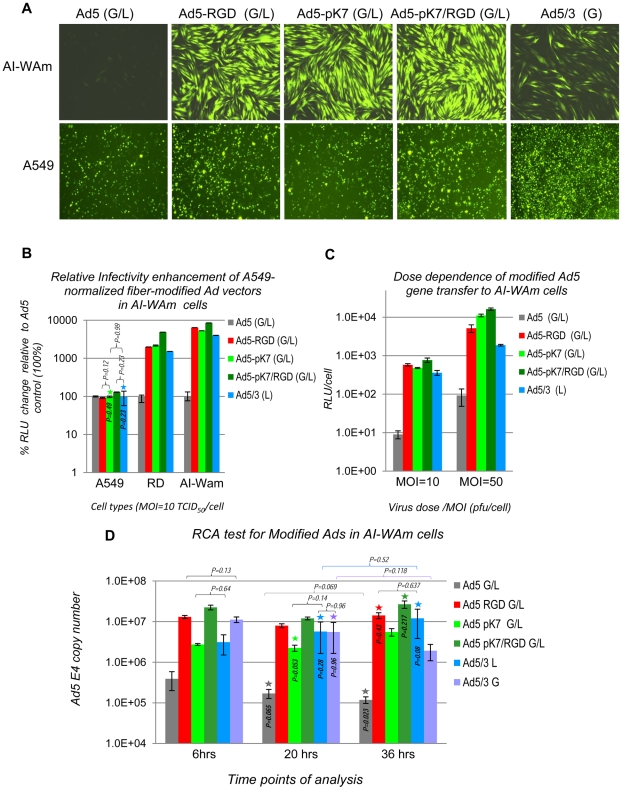
Augmentation of Ad5 gene transfer to AI-WAm cells by Ad5 vectors with various fiber modifications.
A. Representative fluorescent microscopy images of cells infected with the array of recombinant Ad5 vectors with genetically-modified fibers shown on Fig. 4. Relative gene transfer efficiencies in the AI-WAm and A549 cells were assessed by fluorescent microscopy of GFP-expressing cells transduced with the array of modified vectors 20 hrs post infection; (G/L) indicates the presence of two reporter genes (GFP and Luc) each under control of its own CMV promoter; (G) denotes a single-reporter GFP cassette. Infection with Ad5 (G/L) was performed at an MOI of 50 TCID50/cell, while doses of other vectors were adjusted by Luc expression to match that of Ad5 (G/L) in A549 cells (see Materials and Methods and Results). A 50 TCID50/cell infection dose was used for Ad5/3 (G) vector for normalization in A549 cells as it could not be adjusted by Luc expression like the other (G/L) vectors. Fluorescent images were captured with 10× objective and exposure time of 2 sec. for A549 cells and 400 msec. for AI-WAm cells. Each vector infection was carried out in triplicates. Shown are images of representative samples; B. Luc assay of lysates prepared from A549, RD and AI-WAm cell samples (same as shown in A) following vector dose normalization in A549 cells using 10 µl of each lysate (100 µl) for bioluminescence analysis. The data are presented as percentage (%) of the Ad5 (G/L) gene transfer efficiency (total RLU) in each cell type taken as 100%; RLU - relative Luc units, (L) - a single firefly Luc reporter expression cassette. Other details are as in Materials and Methods. C. The original Luc assay data of the AI-WAm samples (shown in A and B) presented as RLU per cell. Two different MOIs of Ad5 (G/L) infection were used for dose normalization: 10 and 50 TCID50/cell to illustrate dose dependence of the infectivity enhancement effects. All other details are as in B. D. Test for replication competent adenovirus (RCA) contamination in modified Ad vector preparations by qPCR analysis of Ad genomic DNA. AI-WAm cells were infected with A549-normalized vectors at the doses corresponding to MOI = 50 of the Ad5 (G/L) (C) and harvested 6, 20 and 36 hrs post infection for total DNA isolation. Viral genomes were quantified by qPCR and presented as E4 copy numbers normalized for total cellular DNA quantified by qPCR of the housekeeping (GAPDH) gene. No statistically significant increase in internalized genomic DNA evidences the lack of RCA-induced genomic DNA replication at 20 hours post infection (time point of Luc assay), suggesting that the reporter gene expression has not been affected for any vector. Color coding and other details are as in B and C. Stars above bars with the corresponding colors indicate changes relative to the 6 hr time point values with no statistical significance. P values (>0.05) are shown on the corresponding bars. Color brackets (with P values on the top) indicate value changes between 20 hr and 36 hr time points; black brackets (with P values on the top) show sample differences of no statistical significance (P>0.05) within the same time point. All other differences are statistically significant (P<0.05).